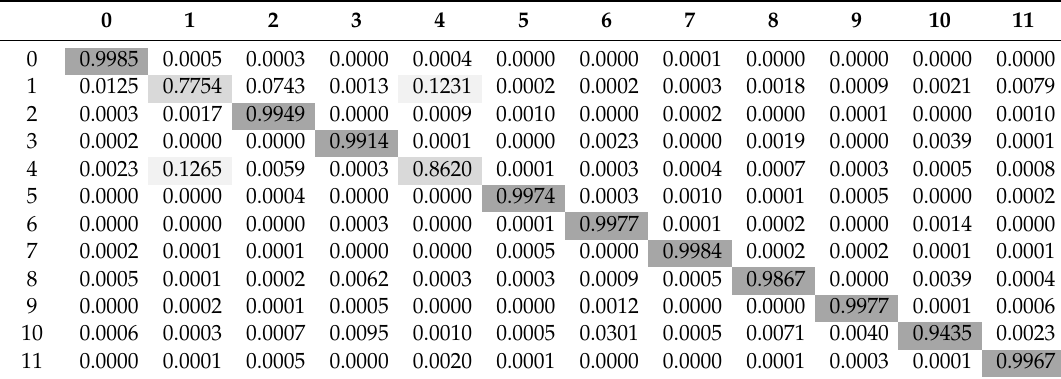
Table 6. Load image classification confusion matrix. Figure 14. Feature image after pooling and non-linear operation.